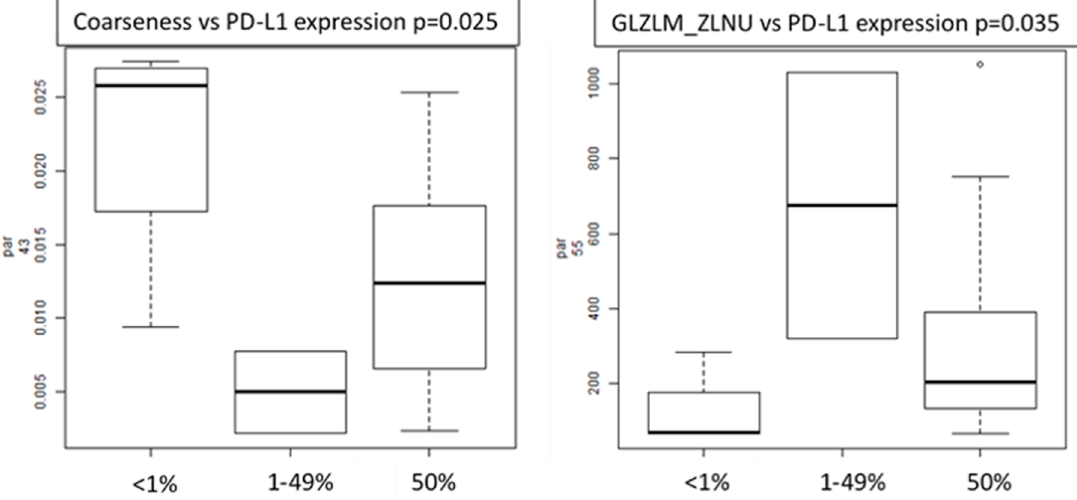
Figure 3. Box plots of radiomics features (coarseness and GLZLM_ZLNU) showing correlation with PD-L1 expression.